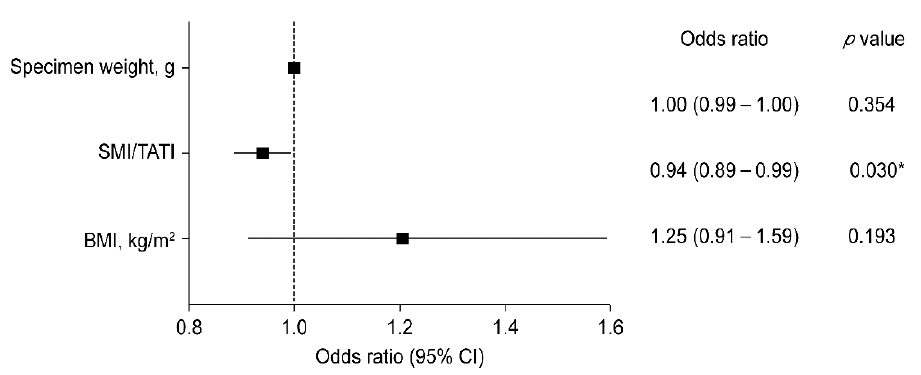
Figure 2. Forest plot of multivariate logistic regression model analysis for NAC ischemia. CI, confidence interval; SMI, skeletal muscle index; TATI, total adipose tissue index; and BMI, body mass index. * p < 0.05.